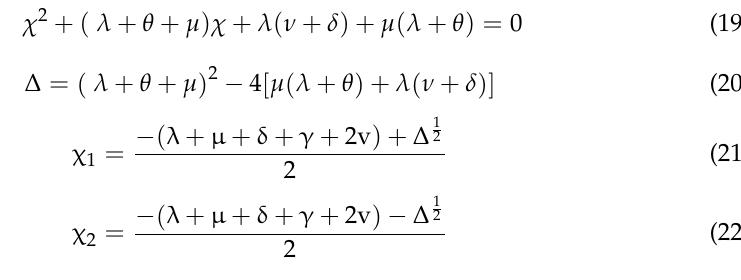
Table 2. Type of critical points and stability based on the eigenvalues and determinants [5]. Eigenvalues Type of Critical Point Stability χ 1 > χ 2 > 0 Node Unstable χ 1 < χ 2 < 0 Node Asymptomatically stable χ 2 < 0 < χ 1 Saddle point Unstable χ 1 = χ 2 > 0 Proper or improper node Unstable χ 1 = χ 2 < 0 Proper or improper node Asymptomatically stable χ 1 = χ 2 = λ ± i µ Spital point Unstable χ 1 = i µ χ 2 = − i µ Center Asymptomatically